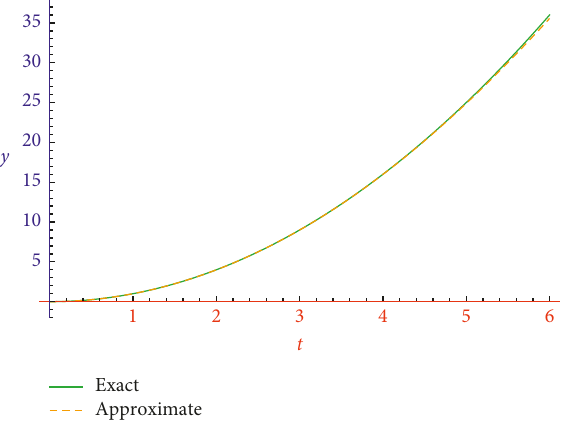
Figure 2: 2D plot for ϑ ( t ) with various parameters of α . Table 1: The absolute error of ϑ ( t ) for different values of t